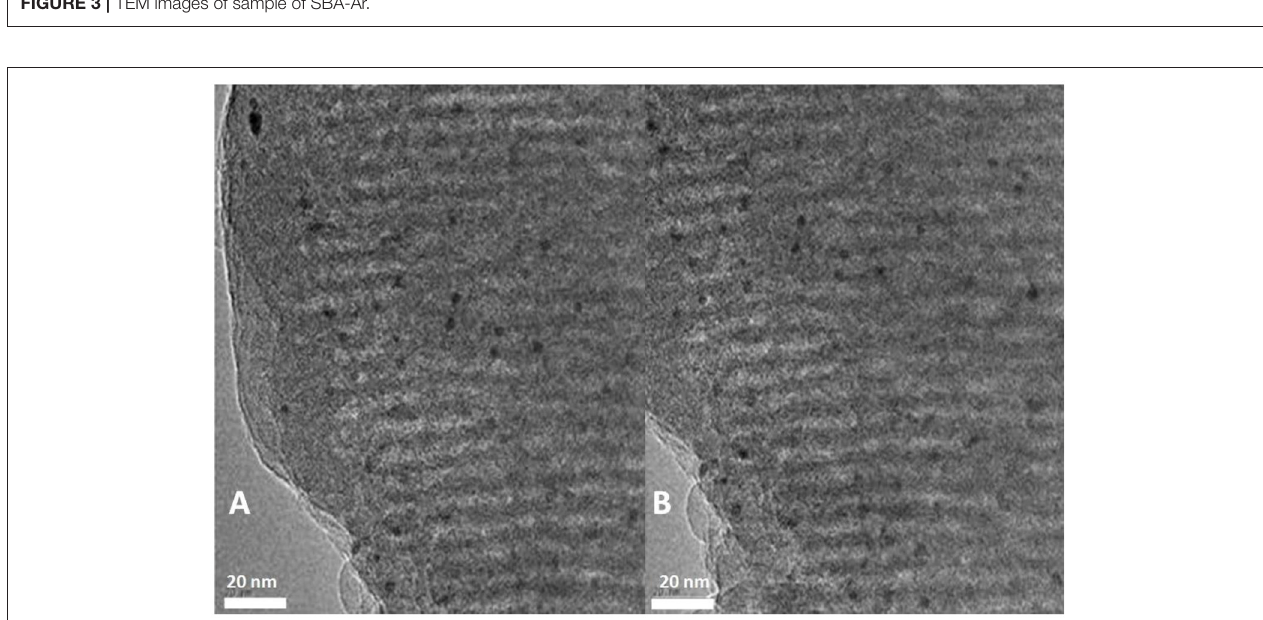
FIGURE 4 | TEM images of 1%Pt/SBA-Pr (A) and 1%Pt/SBA-Ar (B)